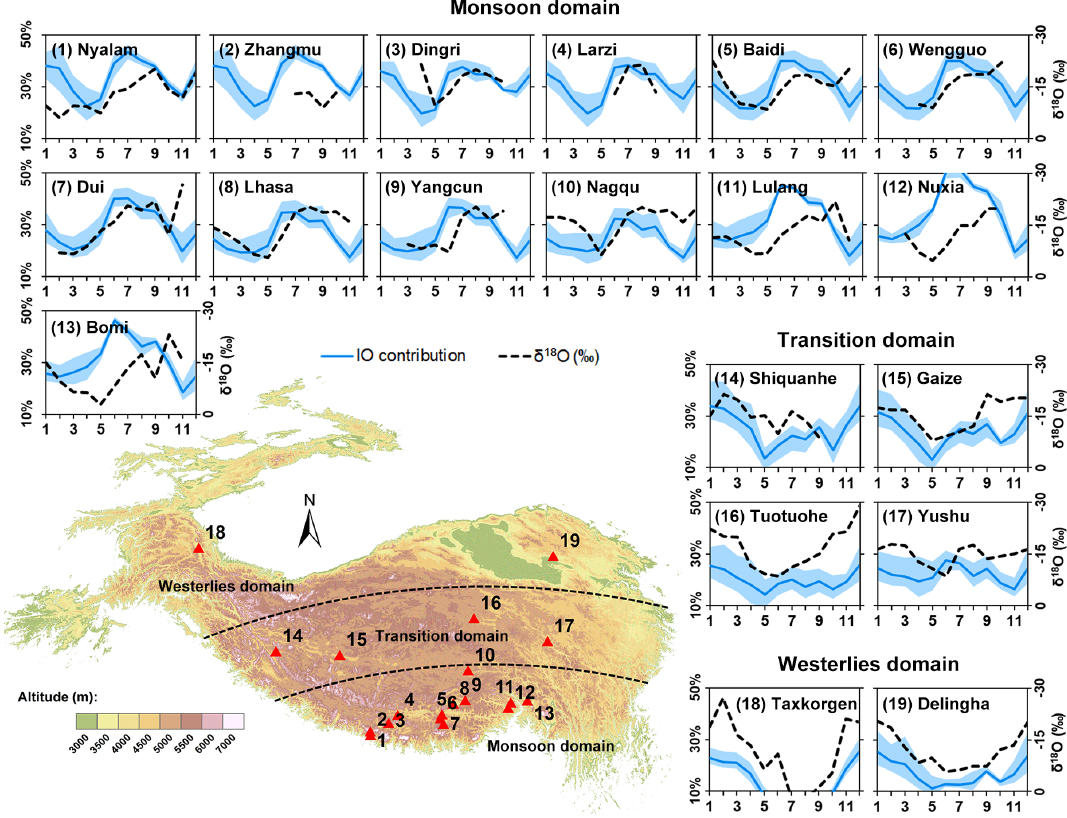
Figure 8. Locations of the precipitation isotope monitoring stations and the relationship between the monthly relative IO moisture contri- butions (blue lines) and the precipitation isotope observations (dotted lines). Sites 1–13, 14–17 and 18–19 represent stations located within the monsoon domain, transition domain and westerlies domain, respectively. Blue lines show the mean IO moisture contributions based on three simulations, while the shadings show the range (detailed seasonal variations of three simulations are shown in Fig. S14). Note that for consistency, oceanic contributions below 10% and above 50% are not shown for sites 12 and